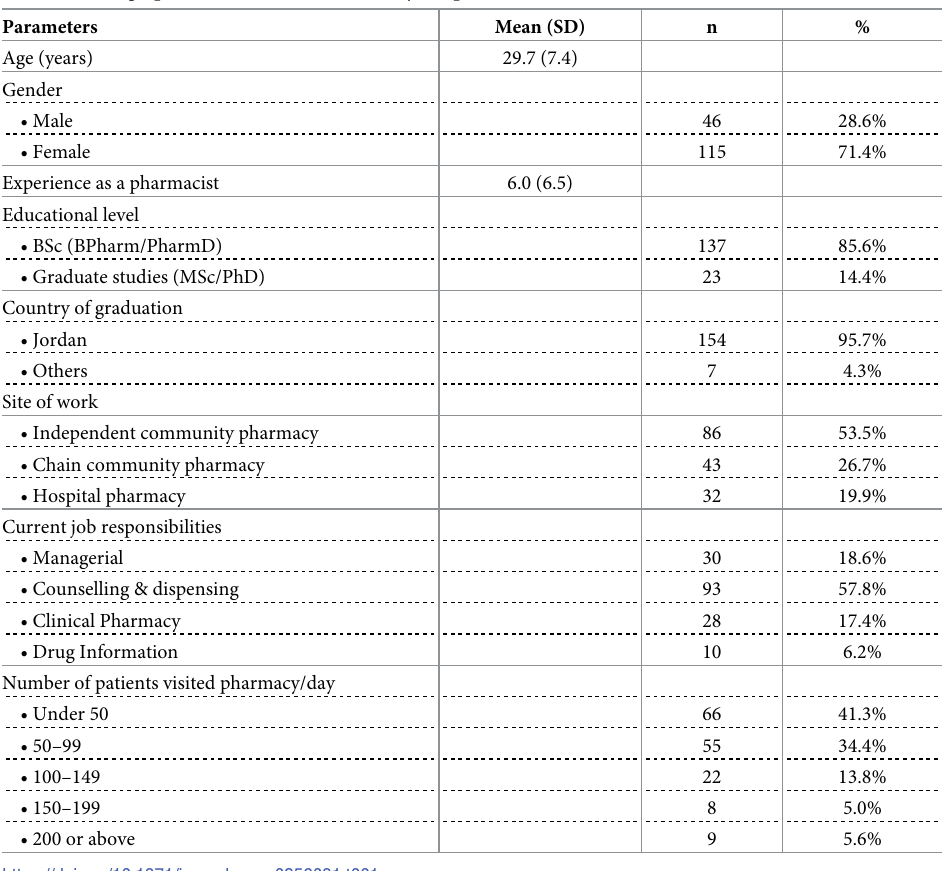
Table 1. Demographic characteristics of the study sample (n =